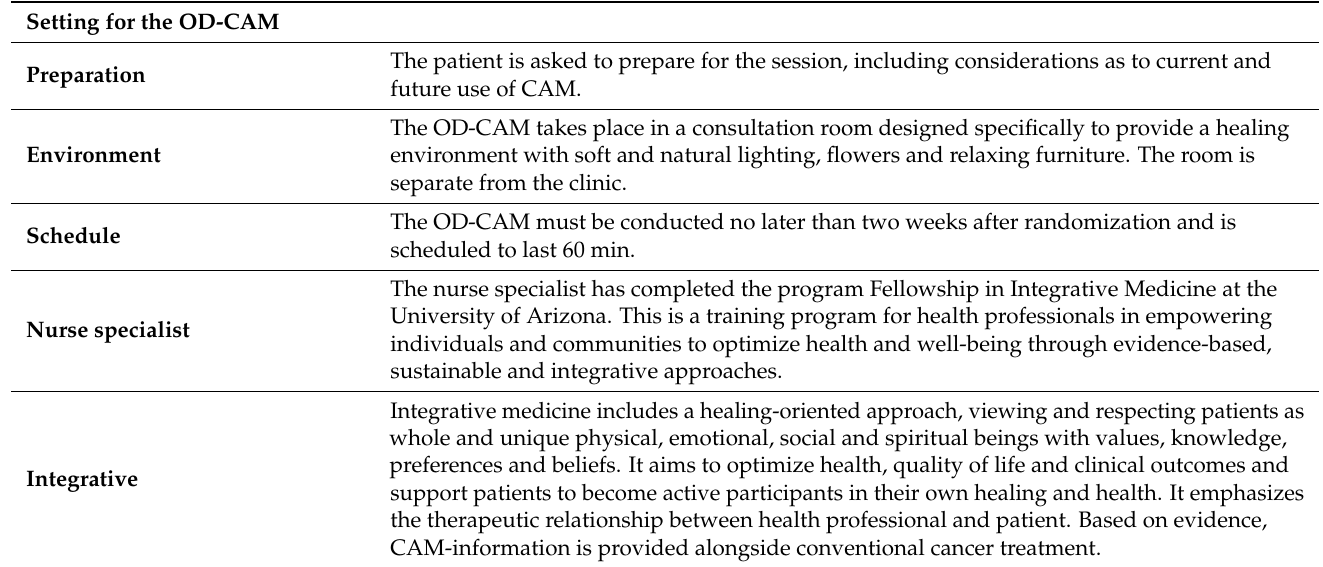
Table 1. Guidelines for open dialogue about complementary alternative medicine: